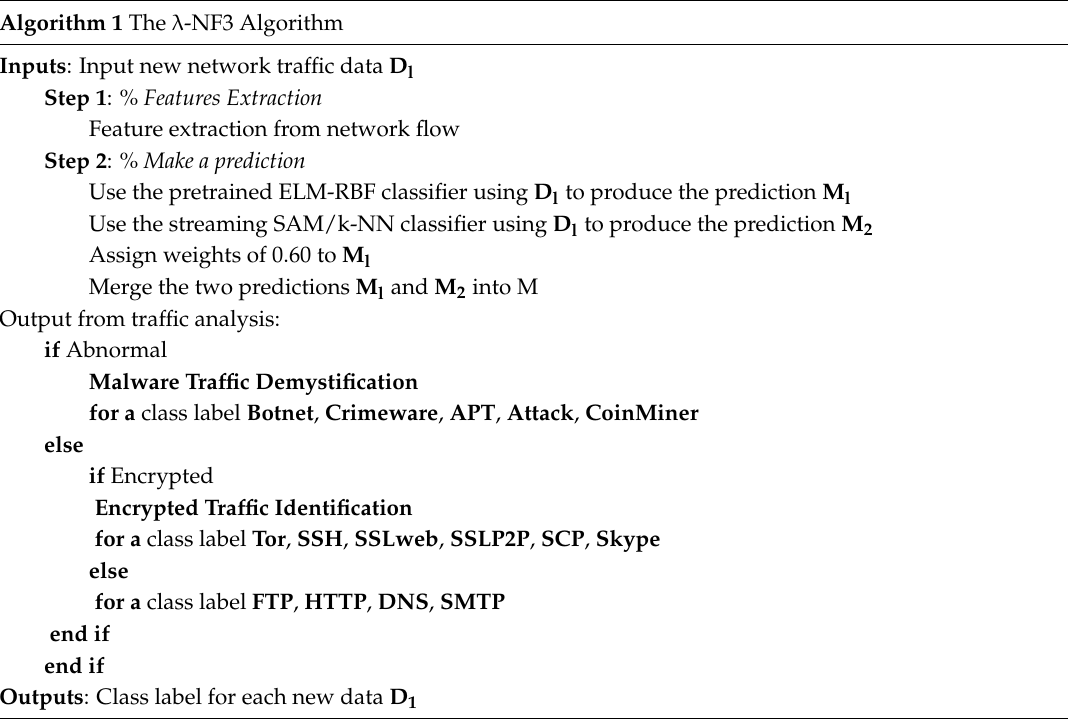
Algorithm 1 The λ -NF3 Algorithm 1 The λ-NF3 Algorithm